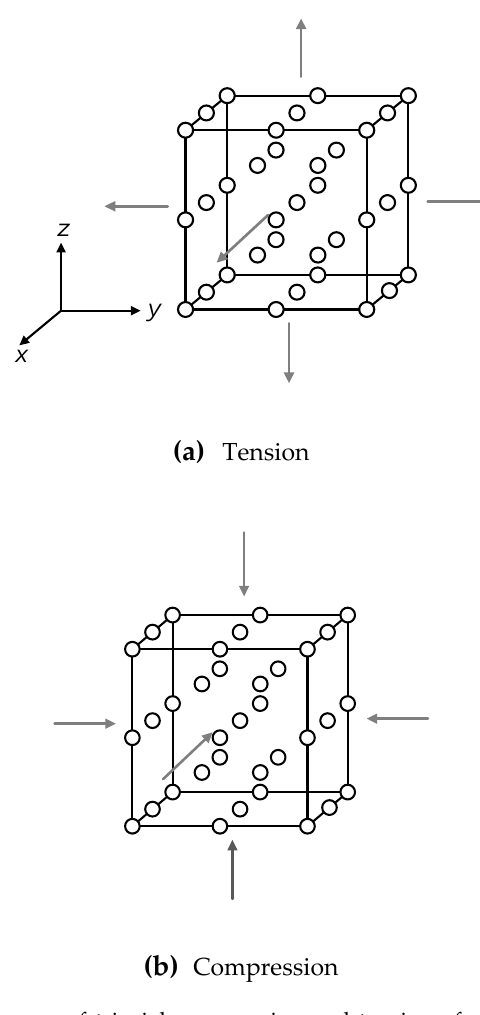
Figure 2. Schematic diagram of triaxial compression and tension of supercell. ( a ) Tension, and ( b ) compression.